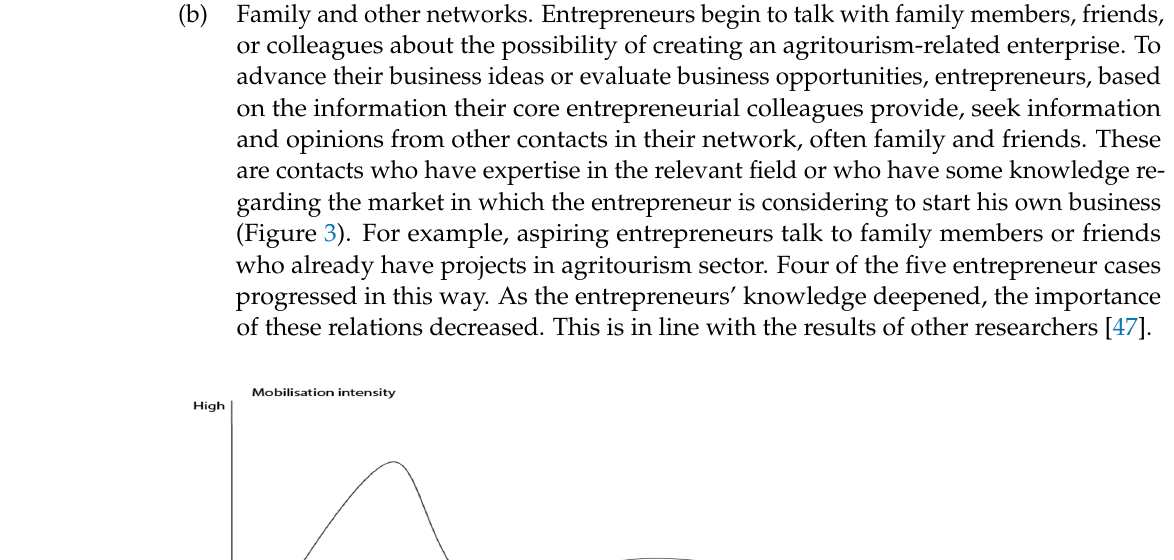
Figure 2. Mobilization of the knowledge and information network.